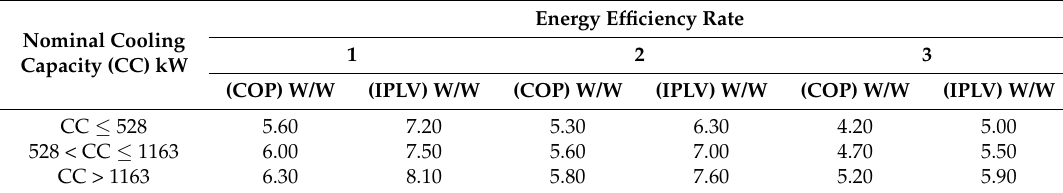
Table 2. Energy efficiency rating of water-cooled chiller energy efficiency.